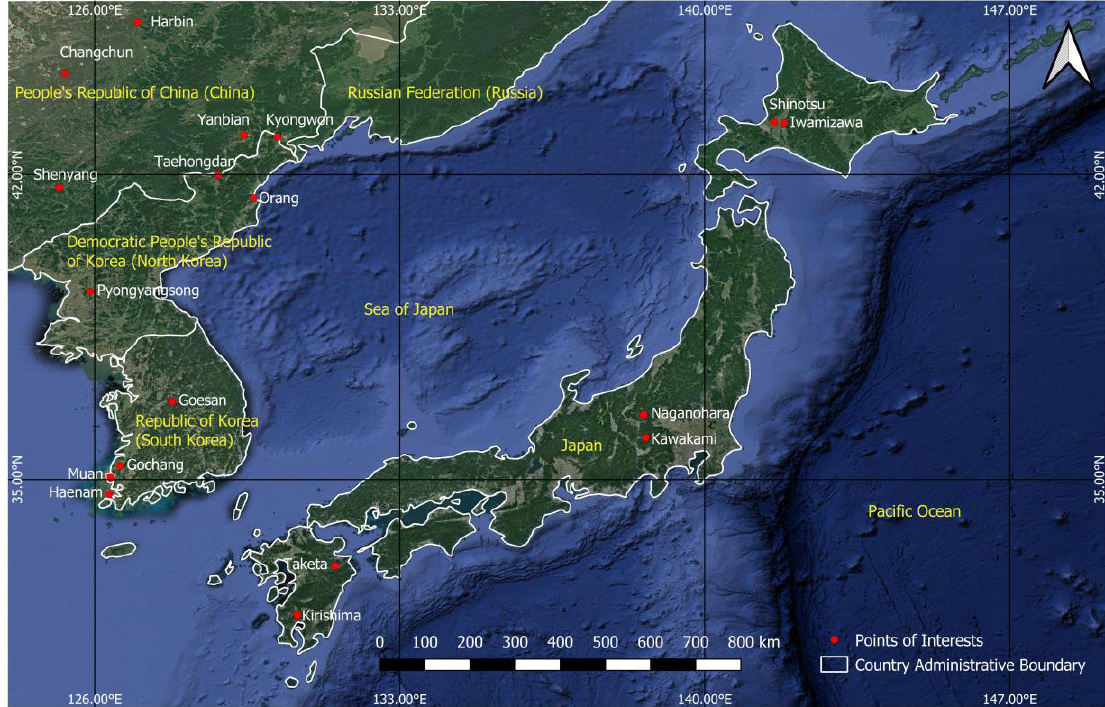
Figure 1. Map of the study area.